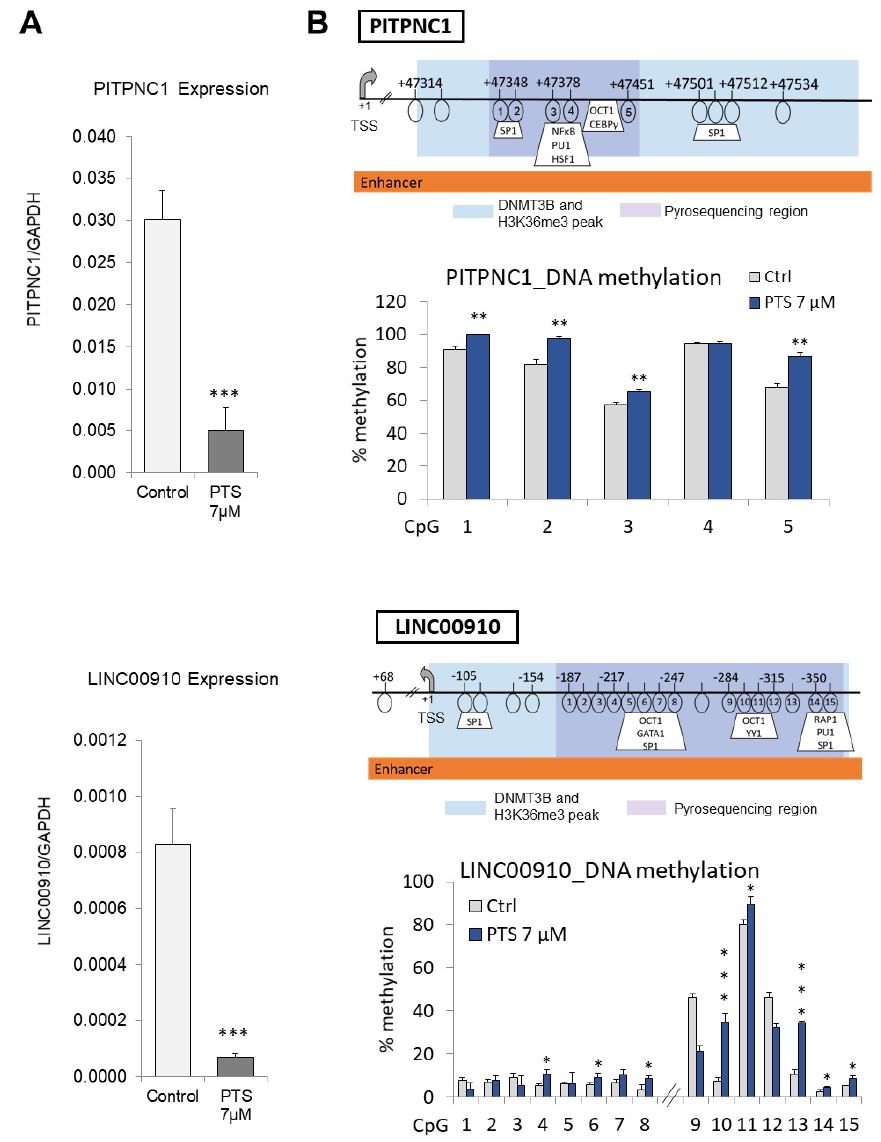
Figure 3. Increased DNMT3B binding and reduced H3K36me3 occupancy is associated with PITPNC1 and LINC00910 downregulation and hypermethylation of the enhancer regions in response to PTS in breast cancer cells. ( A ) PITPNC1 and LINC00910 expression upon 9-day treatment of MCF10CA1a breast cancer cells with 7 µ M PTS as determined by QPCR. ( B ) Average methylation status of CpG sites within PITPNC1 and LINC00910 enhancer regions as determined by pyrosequencing in MCF10CA1a breast cancer cells treated for 9 days with 7 µ M PTS. Gene maps show transcription start site (TSS) indicated by +1, transcription factors predicted using Transfac, and pyrosequenced CpG sites circled and numbered. The blue-shaded fragment in the gene map represents the DNMT3B-increased and H3K36me3-reduced overlapping peaks. The purple-shaded regions refer to a region tested in pyrosequencing. All results represent mean ± SD of three independent experiments; *** p < 0.001, ** p < 0.01, * p < 0.05. Gene downregulation and DNMT3B binding could suggest that DNA methylation within the enhancers of the tested genes underlies gene silencing. We next measured the DNA methylation status of PITPNC1 and LINC00910 by pyrosequencing. Gene maps show the exact positions of CpG sites in regions of differential occupancy of DNMT3B and H3K36me3 relative to the transcription start site (+1, TSS) (Figure 3B). The results confirmed that the enhancer of PITPNC1 with 5 CpG sites was significantly hypermethylated by